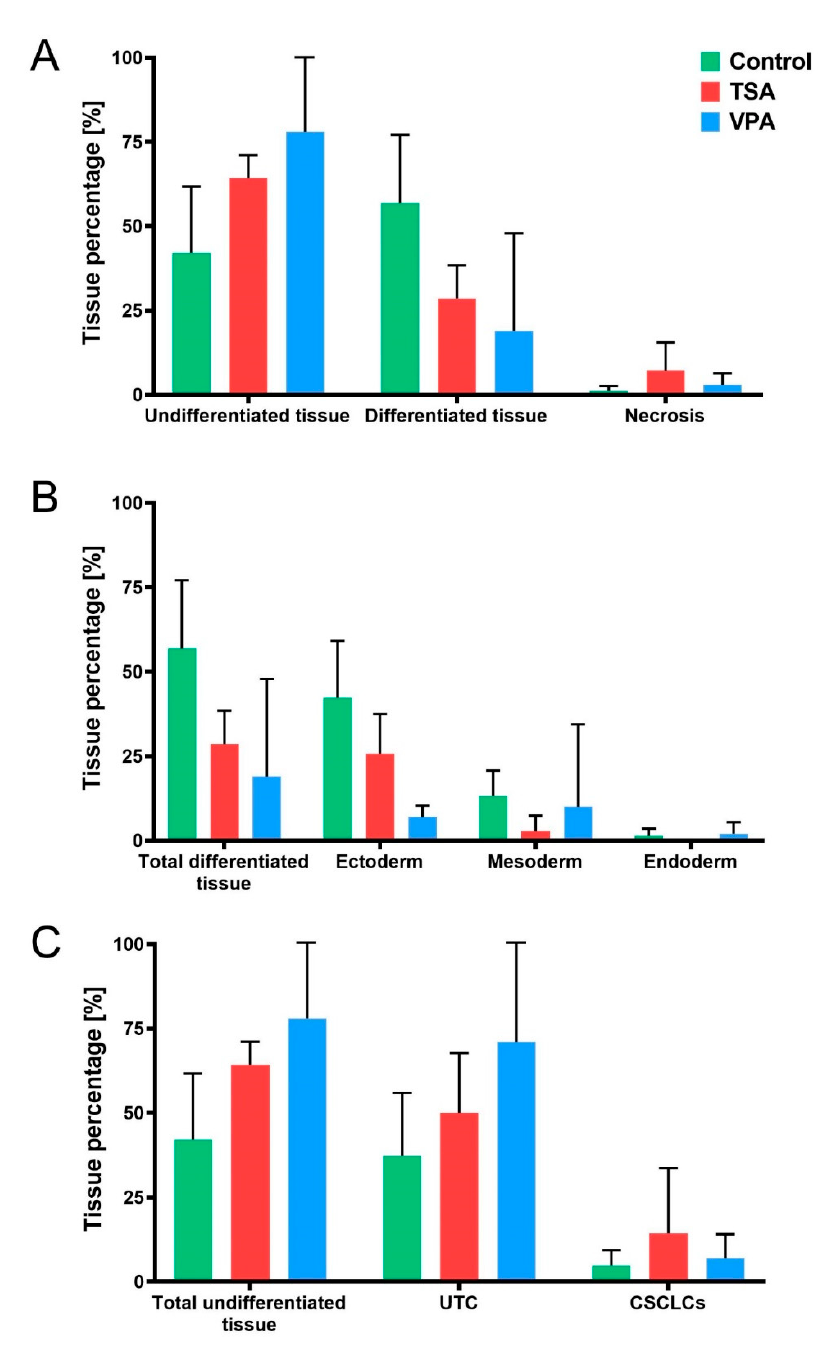
Figure 5. Teratoma tissue distribution. ( A ) Teratoma tissue components across treatment groups, divided into undifferentiated tissue, differentiated tissue and necrotic tissue. ( B ) Tissue differentiation according to germ layer of origin, with percentage of differentiated tissue depicted as belonging to ectodermal, mesodermal or endodermal tissue across treated groups. ( C ) Stratification of undifferentiated teratoma components into undifferentiated teratoma cells (UTC) and cancer stem cell-like cells (CSCLCs). Values represented are means with 95% CI.